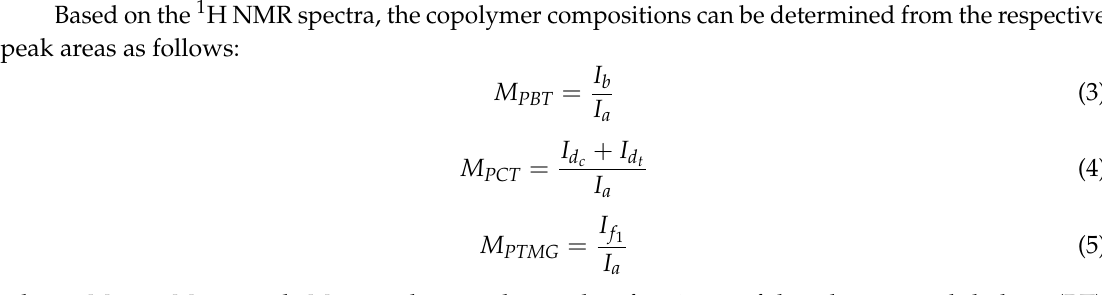
Figure 3. 1 H nuclear magnetic resonance spectra of sample PCT50.